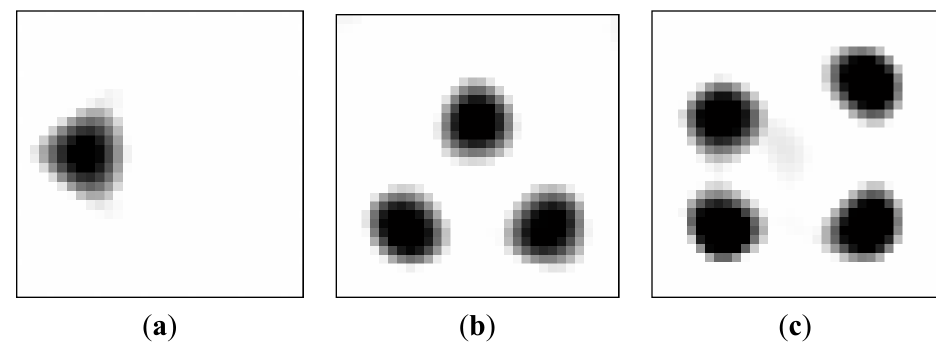
Figure 3. Reconstructed images by the PLI algorithm.